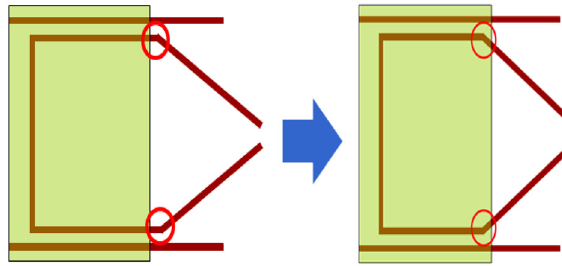
Fig. 18. Bent parts embedded in concrete